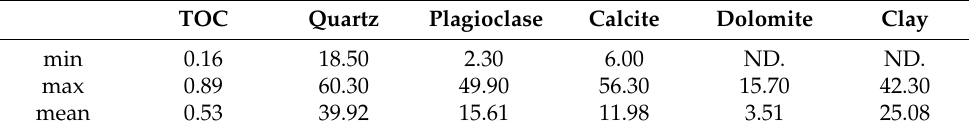
Note: “ND.” means not detected. Table A3. Maximum, minimum, and mean values of TOC and main minerals of soil in Bayannur City. TOC Quartz